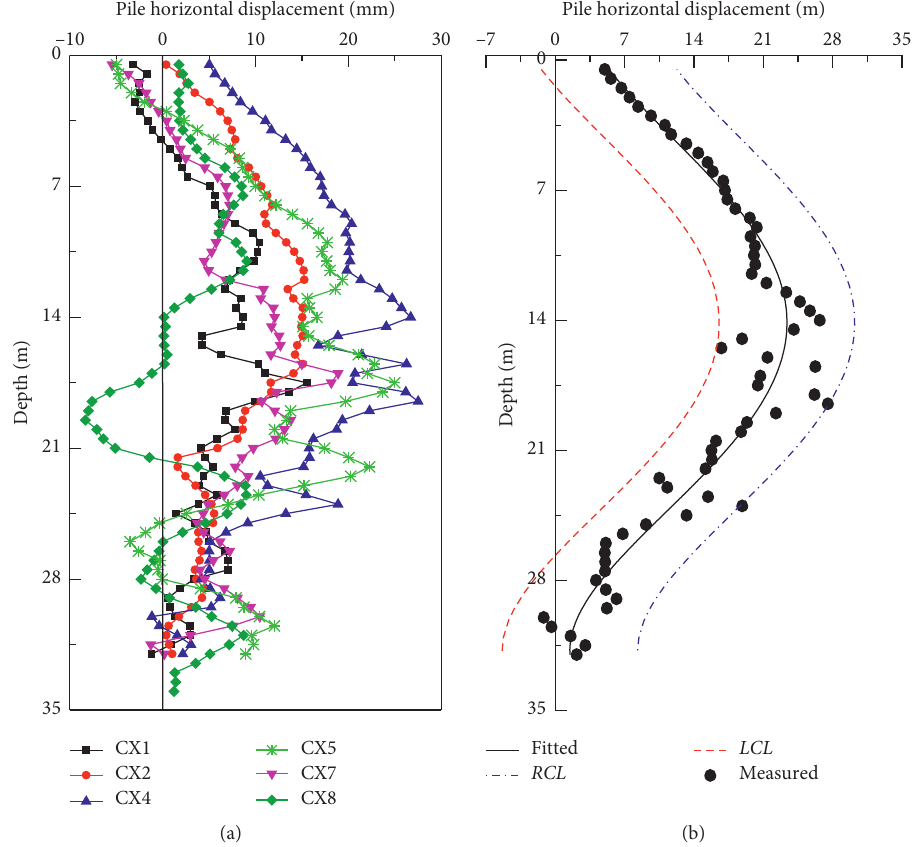
Figure 4: Final lateral displacement curves of CX4 pile body associated with control lines: (a) horizontal displacement; (b) control lines.